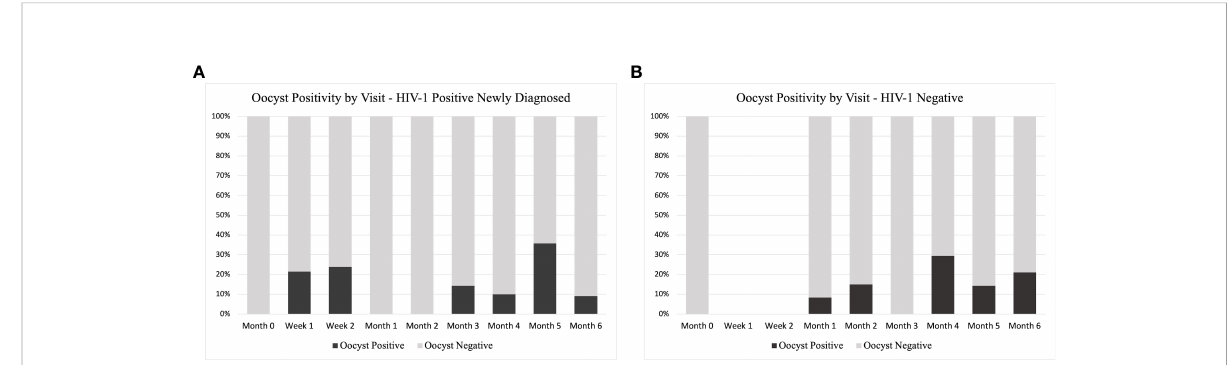
FIGURE 9 Oocyst Positivity by Study Group and Time. A distribution of the total number of oocyst positive samples as percentage of the total analyzed at each time point for (A) HIV-1 positive newly diagnosed volunteers and (B) HIV-1 negative volunteers. As part of the study design, HIV-1 negative volunteers did not have a scheduled visit at week 1 or week 2, so no samples were analyzed at these time points.